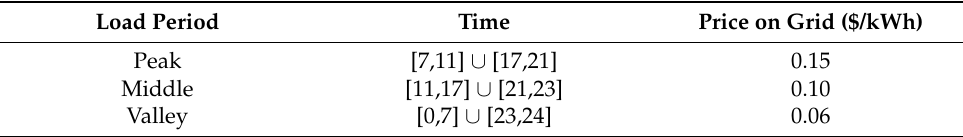
Table 1. Prices of wind